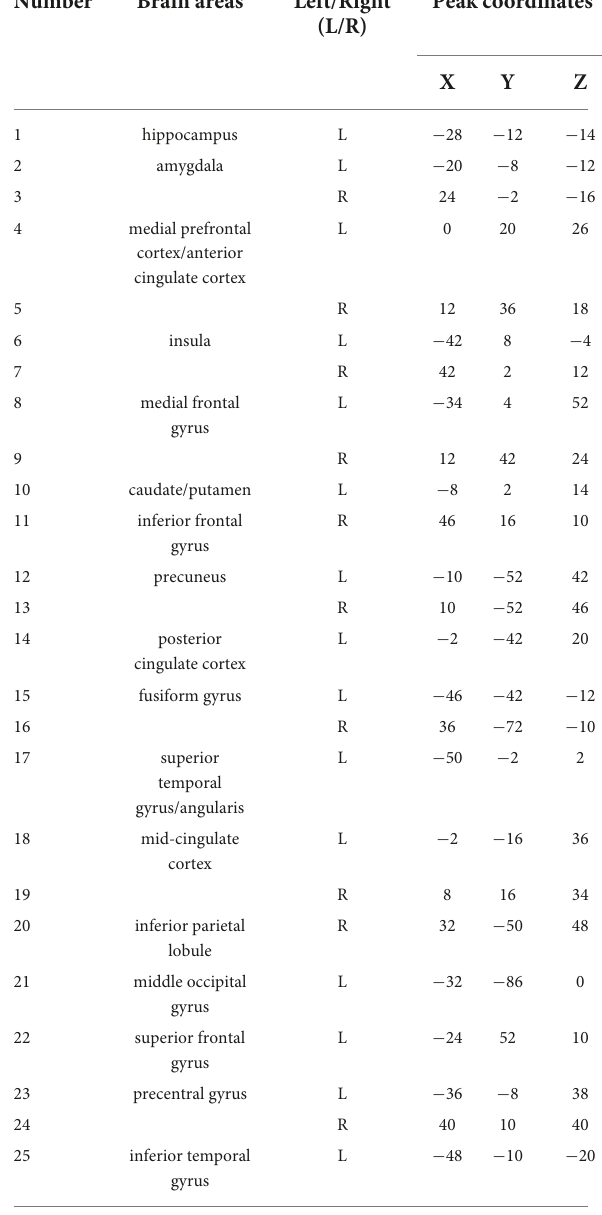
TABLE 2 Coordinates-region-of-interests (ROIs).